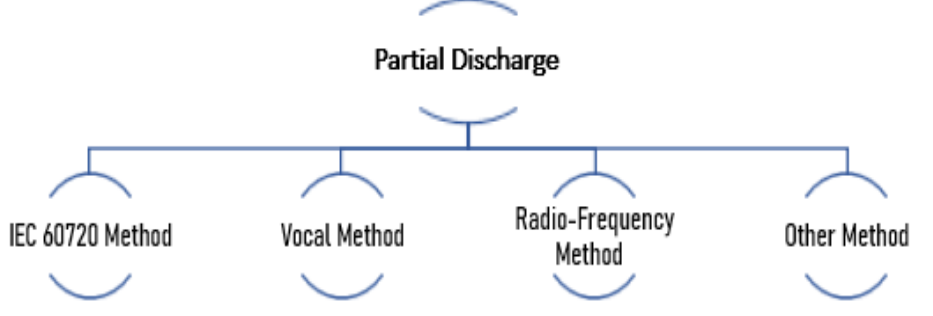
Figure 16. Summary of PD data collection methods .